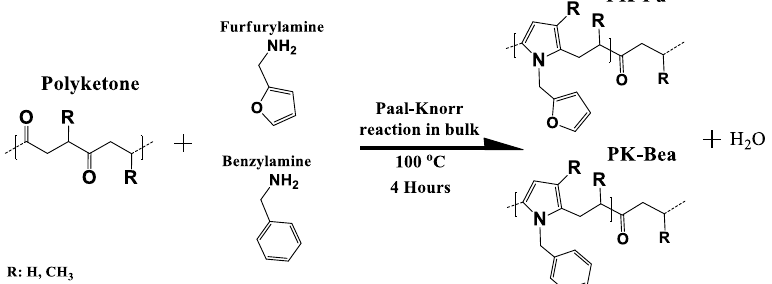
Figure 1. Schematic representation of PK functionalised with furan (PK-Fu) or benzyl (PK-Bea) groups via Paal-Knorr reaction.